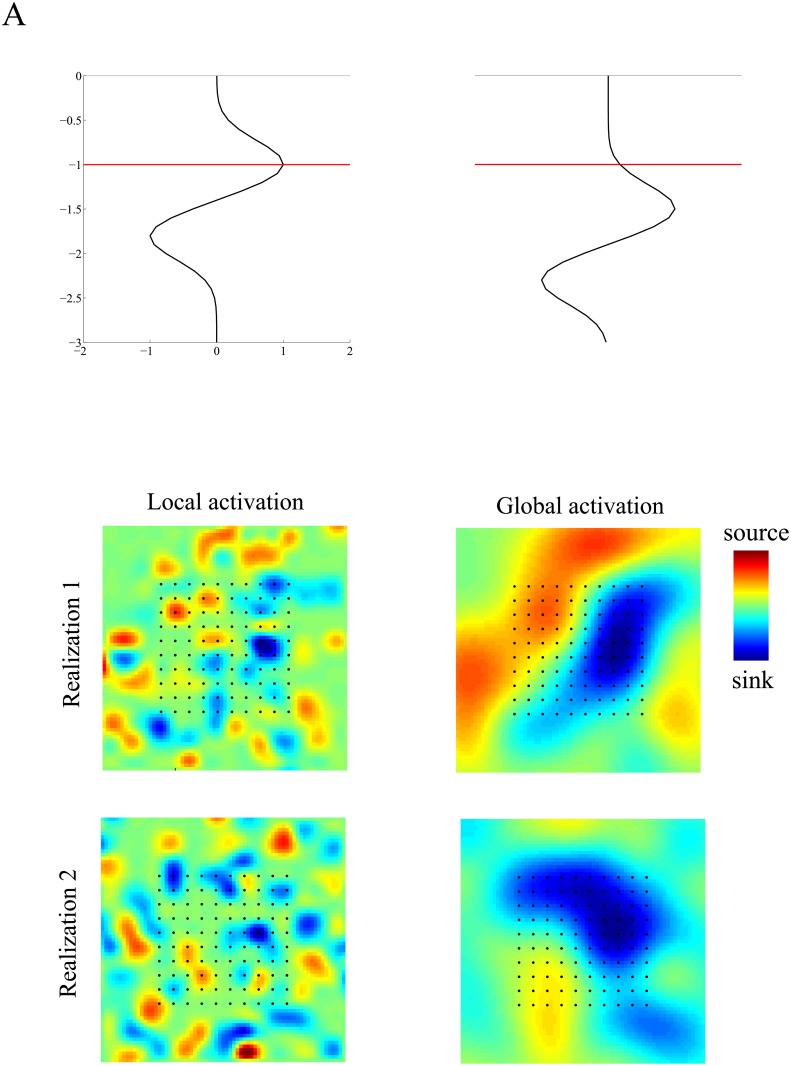
Simulation of evoked current source densities.A. Inter-laminar current source density (CSD) component modeled by superficial (left) or deep (right) dipolar profiles. Deep and superficial are with respect to the electrode array, which is located at a depth of 1 mm (red line). Zero mm corresponds to the pial surface. B. Two (independent) realizations of simulated intra-laminar CSD components corresponding to local (left column) and global (right column) activations. Red and blue correspond to current sources (depolarization) and current sinks (hyperpolarization), respectively. Black dots denote the electrode locations (400 μm inter-electrode spacing).